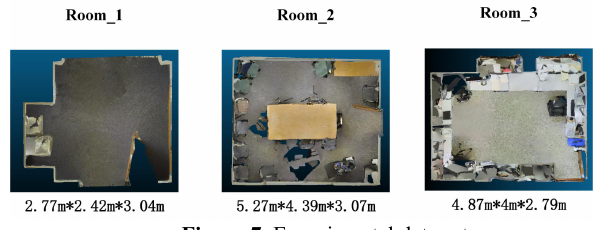
Figure 7. Experimental data set.